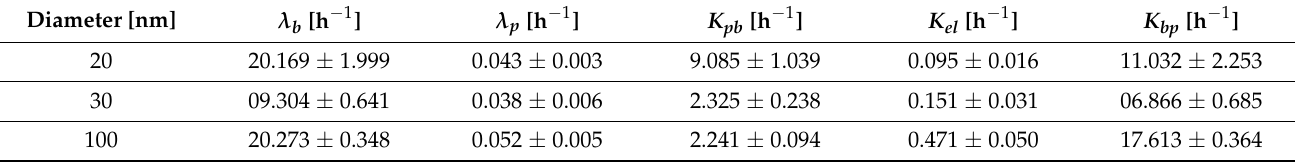
Table 1. Values of K pb , K el and K bp for bionized nanoferrite ® (BNF ® ) nanoparticles. Adapted with permission from Natarajan et al. [20]. Copyright 2008 American Chemical